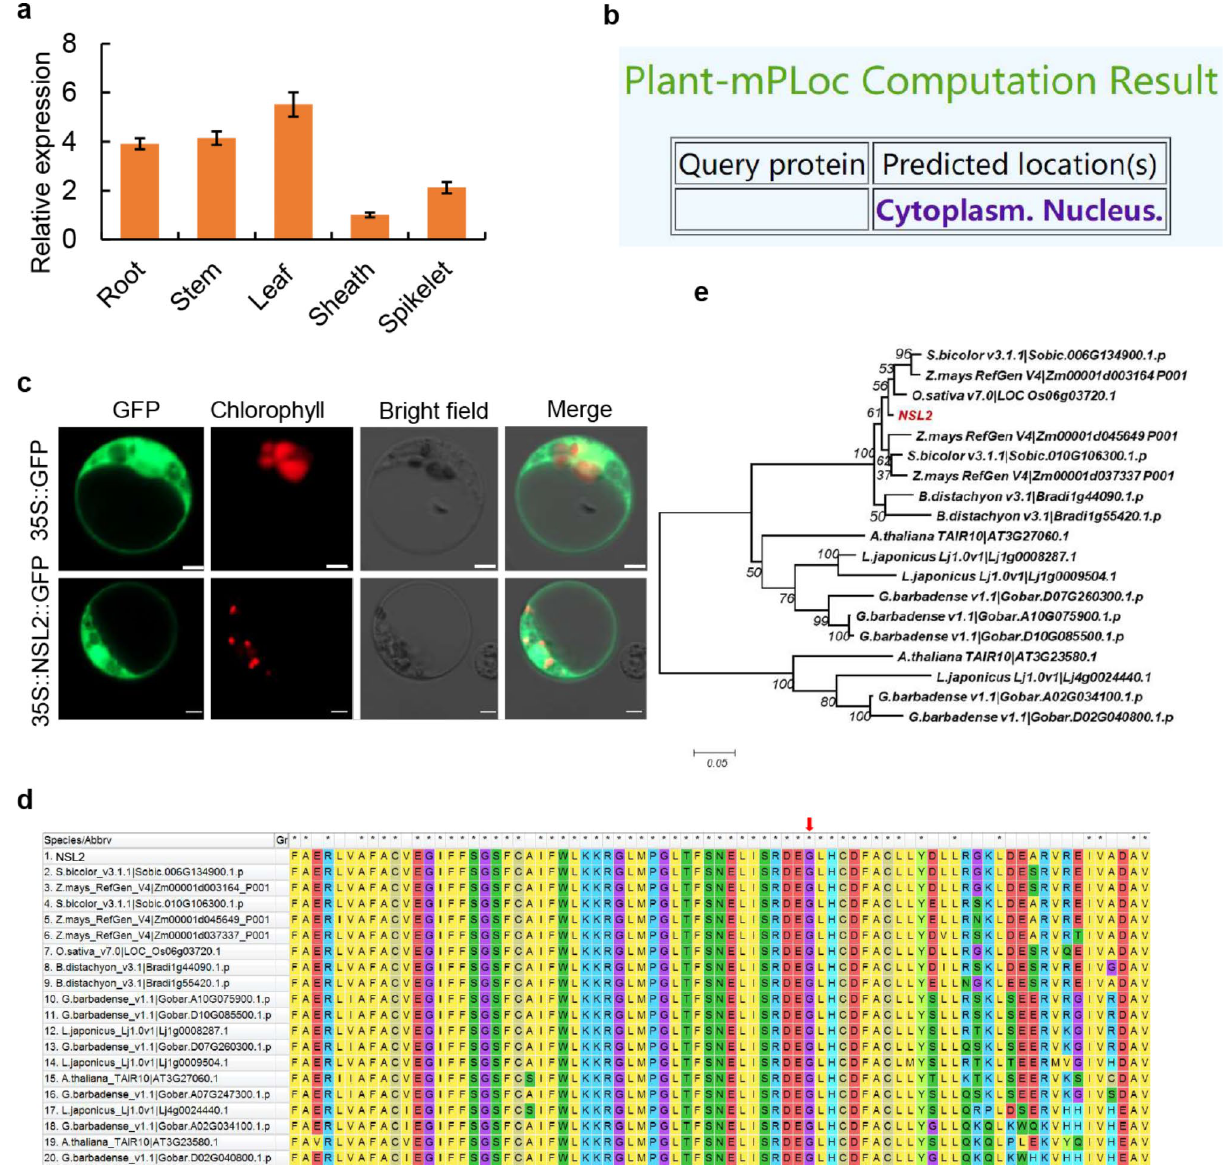
Fig. 4 Expression pattern and protein analysis of NSL2. a : RT-qPCR analysis of NSL2 expression in different tissues of WT normalized to actin. Bars represent mean of three biological repeats ± SD. b : Computation result of NSL2 protein. Using the Plant-mPLoc server (http://www.csbio.sjtu.edu.cn/bioinf/plant- multi/ ) c : Subcellular localization of NSL2-GFP in the transgenic rice leaf protoplasts. d : The conservation of the NSL2 protein sequence analyzed by MEGA 5.1.(The red arrow indicates the amino acid residue mutated in mutant). e : Phylogenetic tree of the NSL2 protein. Bars ( c ) 5